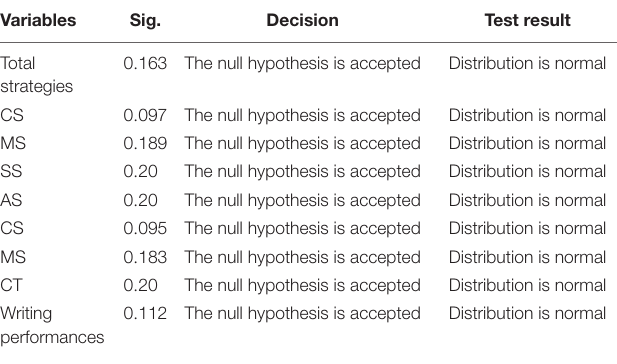
TABLE 2 | Normality tests: One-sample Kolmogorov–Smirnov test. Variables